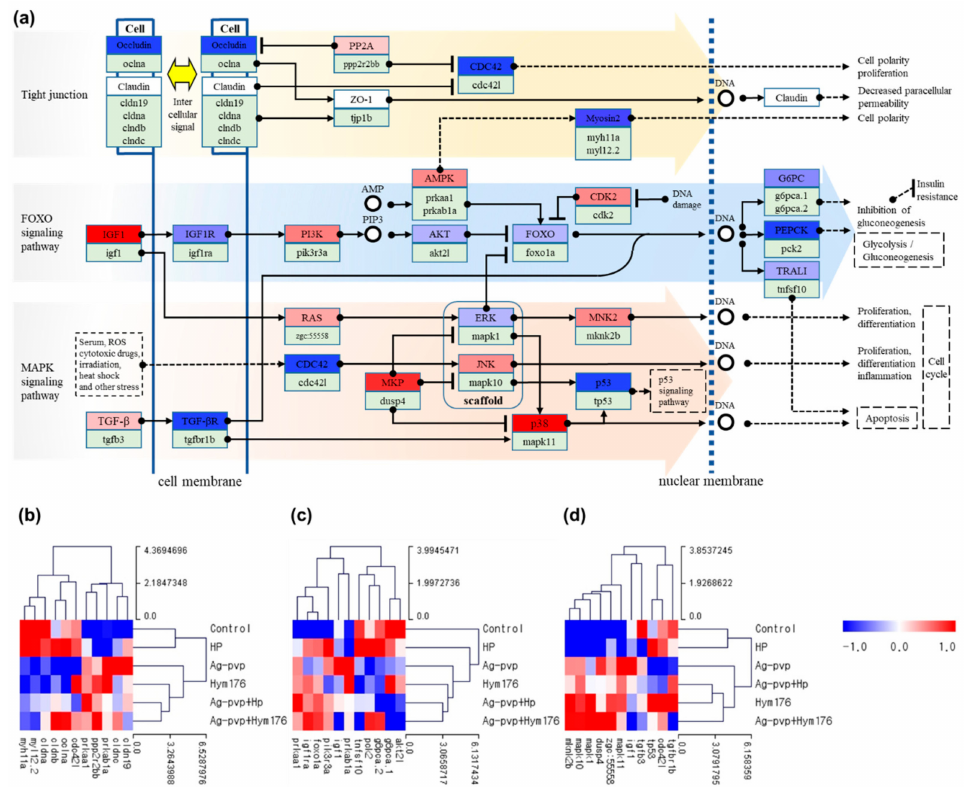
Figure 3. ( a ) Pathway for e ff ects on cell cycle regulation and intercellular signaling in zebrafish exposed to N-Ag-PVP; and heat maps of the ( b ) tight junction, ( c ) fork headbox O (FOXO) signaling pathway, and ( d ) mitogen-activated protein kinases (MAPK) signal pathway. ( b – d ) show the z-scores based on the average of each expressed